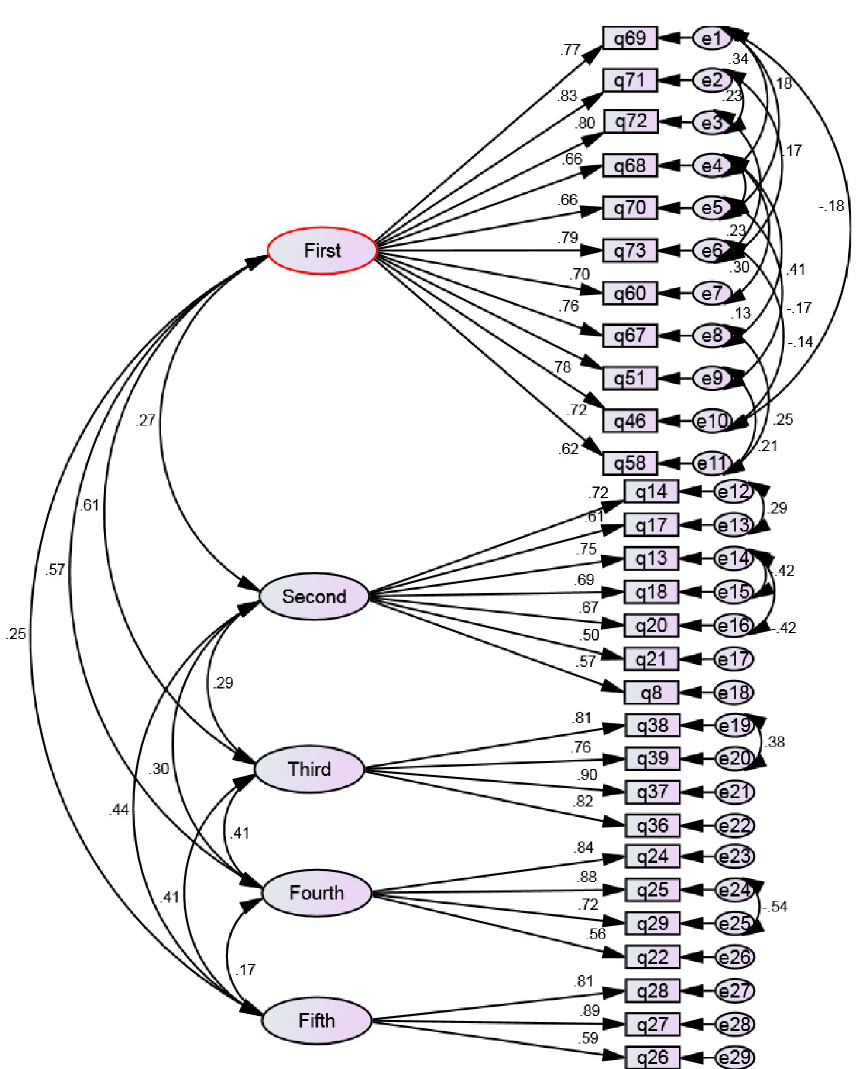
Fig 2. Constructions of evaluation of school resilience in emergencies and disasters: A modified confirmatory factor analysis